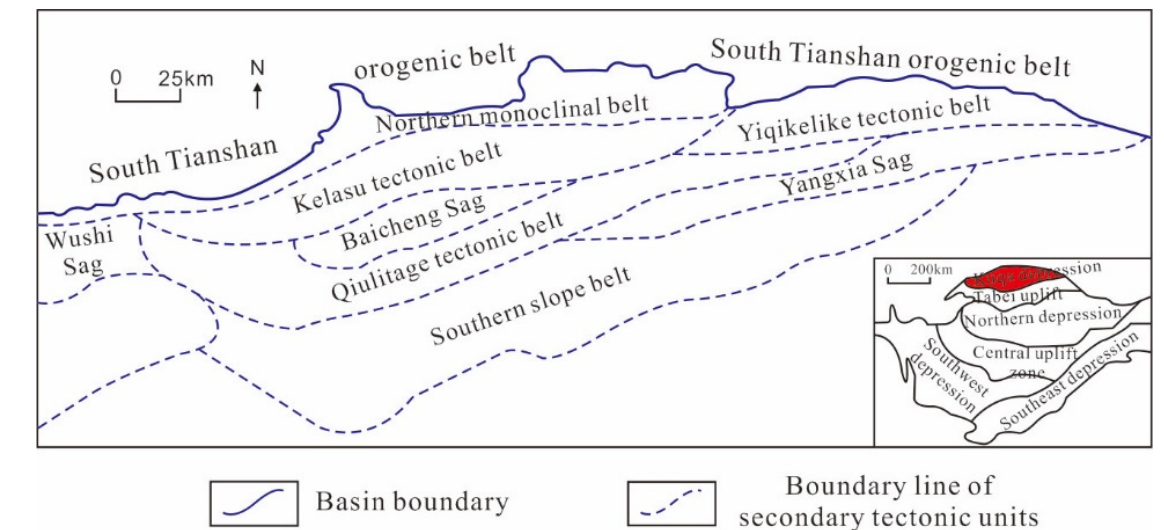
Figure 1. Geographical location of the northern tectonic belt of Kuqa Depression (after Wang et al., 2021 [12]).